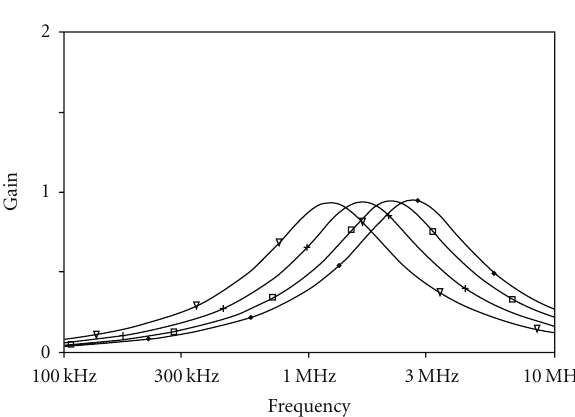
Figure 9: Tunability of pole frequency with bias